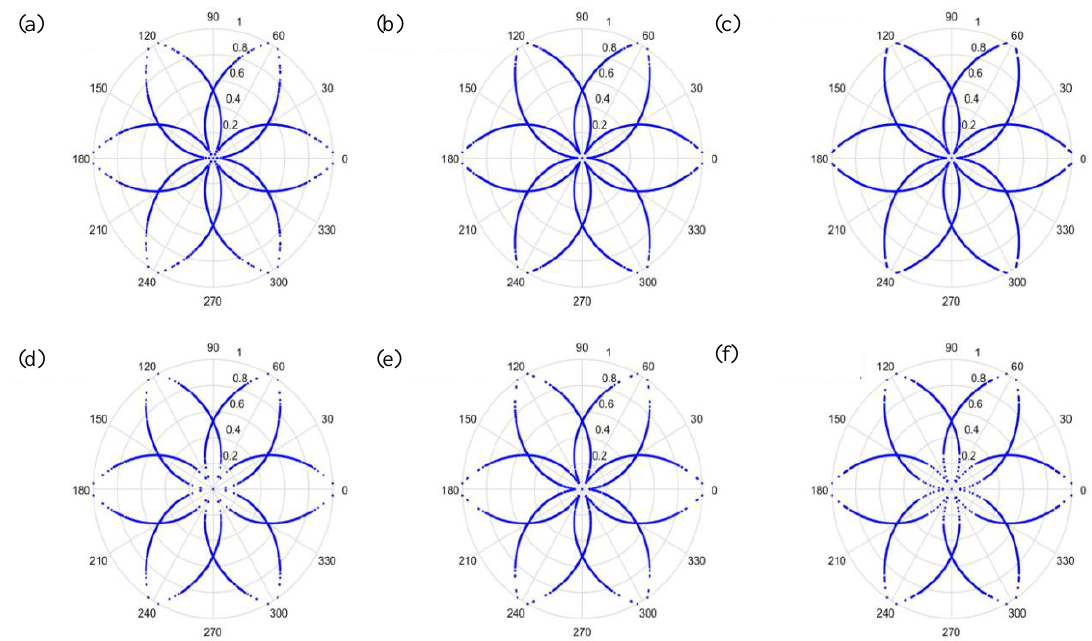
Figure 13. Architecture of the convolutional neural network ( CNN) used for the proposed method.